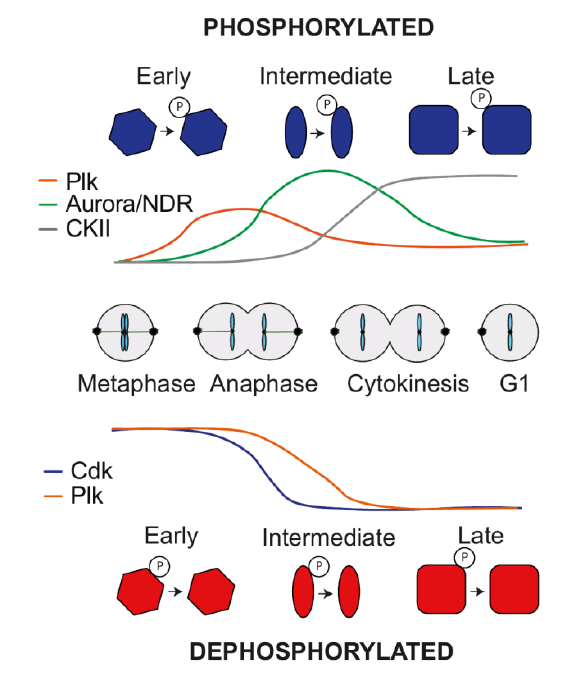
FIGURE 2: Phosphoproteome dynamics during mitotic exit con- trolled by kinases. Scheme summarizing how kinases impact on both protein phosphorylation and dephosphorylation during mitotic exit. Phosphosites carrying Polo-like kinase consensus motifs are phosphorylated early during mitotic exit, followed by Aurora and NDR family kinases and finally casein kinase II (CKII) consensus motifs. In turn, phosphosites displaying a full Cdk consensus motif are dephosphorylated first, followed by minimal Cdk motifs and finally Polo-like kinase